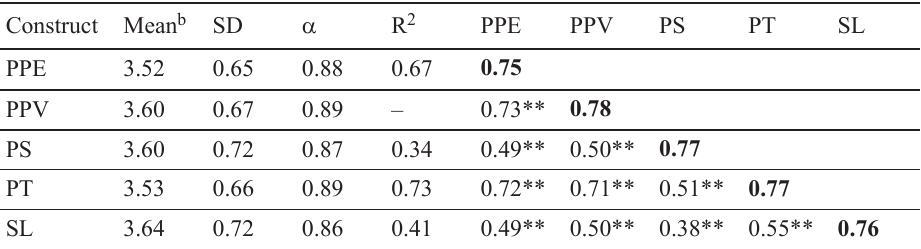
Table 1. Summary analysis of measurement model: factor structure, composite reliability and AVE